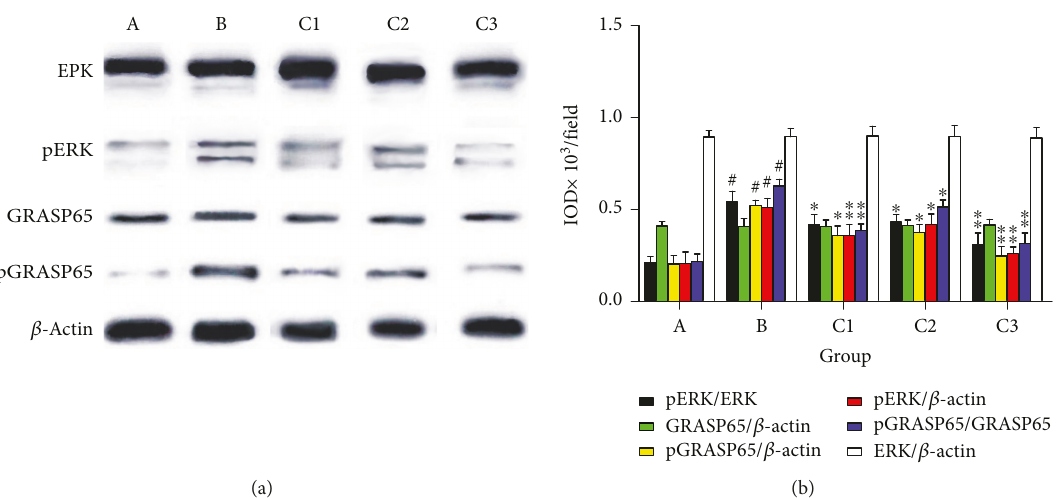
Figure 8: ERK, pERK, GRASP65, and pGRASP65 expressions in mice from each group within 5 days after CIRI. # P < 0 01 versus group A; ∗ P < 0 05 versus group B, ∗∗ P < 0 01 versus group B. Data are presented as the mean ± standard deviation; n = 10 . Group A: sham-operated; group B: control; group C1: pretreatment; group C2: treatment; group C3: pretreatment + treatment; ERK: extracellular signal-regulated kinase; p: phosphorylated; GRASP65: Golgi reassembly and stacking protein